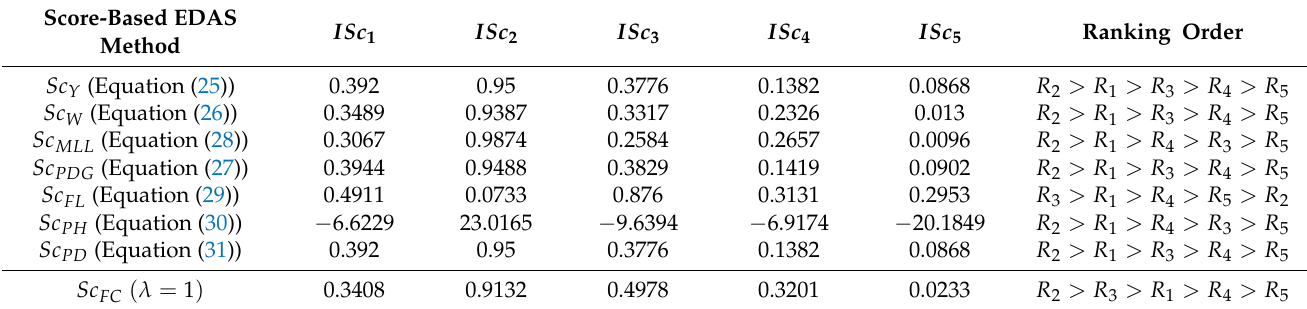
Table 7. Ranking of alternatives with considered score